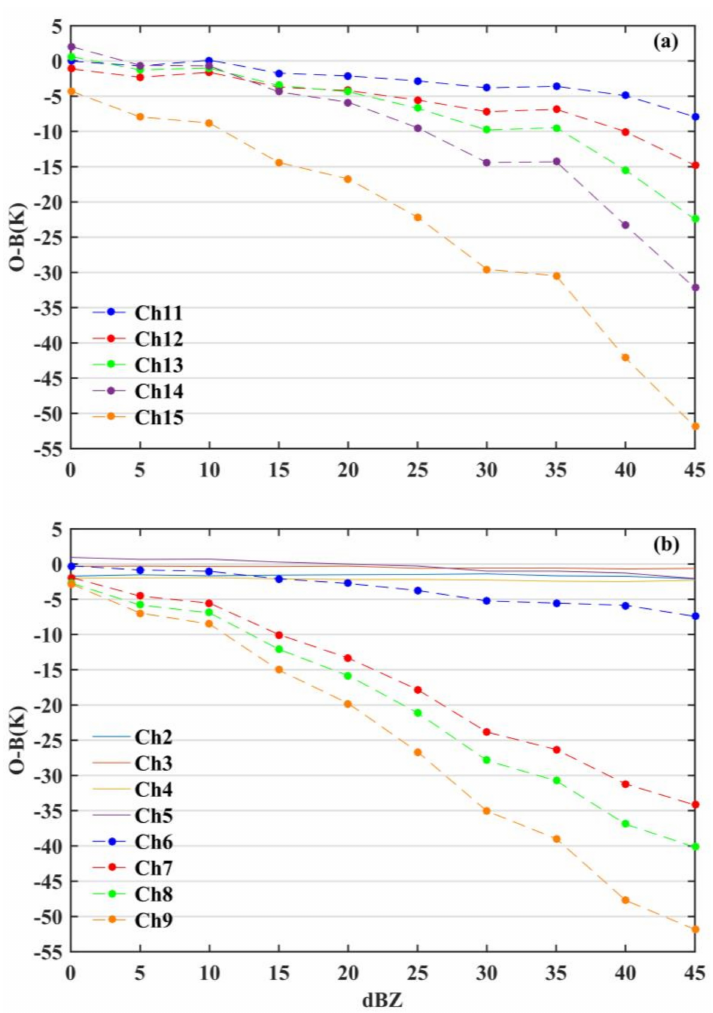
Figure 13. O − B versus radar reflectivity for channels 11–15 ( a ), and channels 2–9 ( b ), with data sampled from July to September in